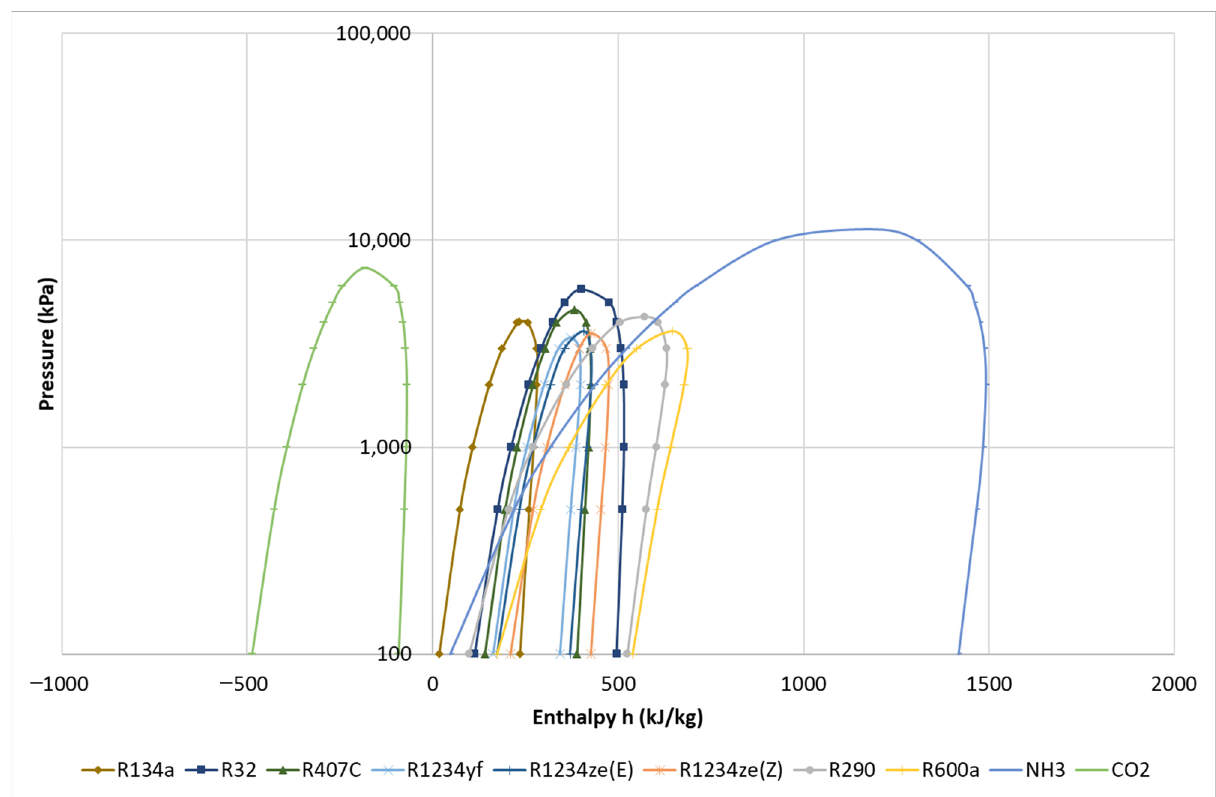
Figure 7. Comparison of P-h diagrams.